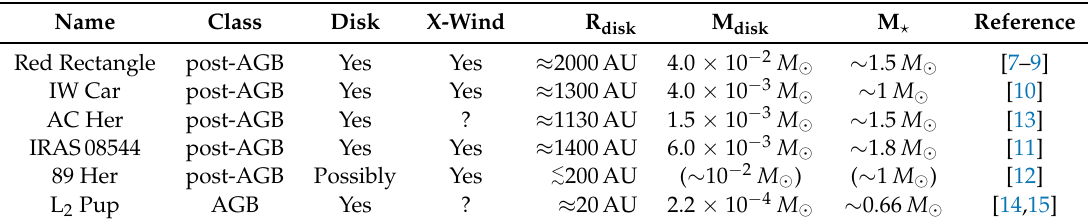
Table 1. Keplerian circumbinary disks with CO interferometric